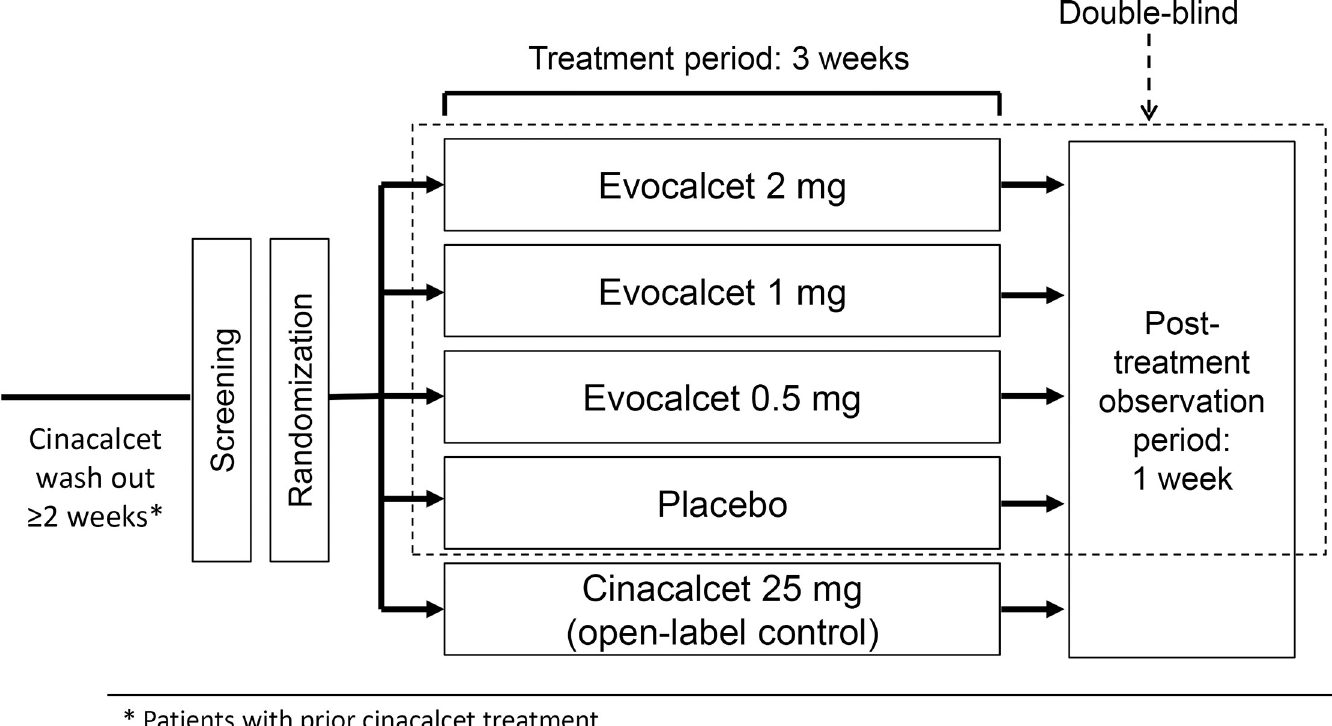
Fig 2. Study design. The area enclosed by the dotted line indicates the double-blind treatment phase. � Patients with prior cinacalcet treatment.